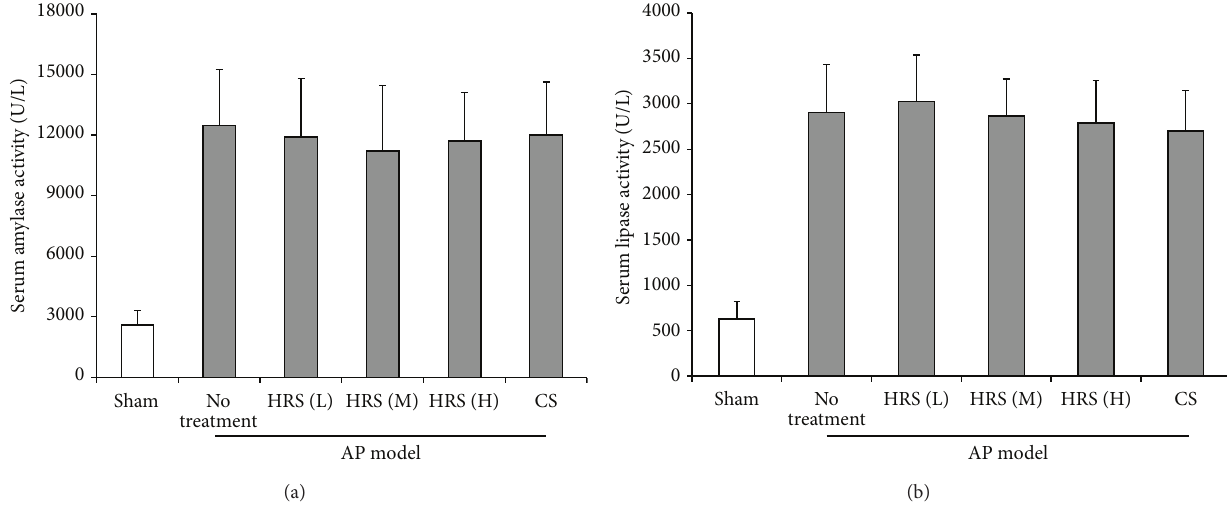
Figure 3: Determination of plasma amylase and lipase activities in mice. Experimental AP model was induced by hourly intraperitoneal injections of cerulein (50 𝜇 g/kg × 6) to mice. Then the HRS at various doses or control saline (CS) was injected intraperitoneally to AP mice 1 h after the final injection of cerulein, respectively. Animals in each group ( 𝑛 = 6 ) were sacrificed by CO 2 asphyxiation 1h after the final administration of HRS, and immediately the blood and tissue samples were collected. The amylase and lipase activities in plasma were determined with a colorimetric method using the commercial kits for amylase and lipase, respectively. L: low dose (2mL/kg × 3); M: middle dose (4 mL/kg × 3); H: high dose (8mL/kg ×